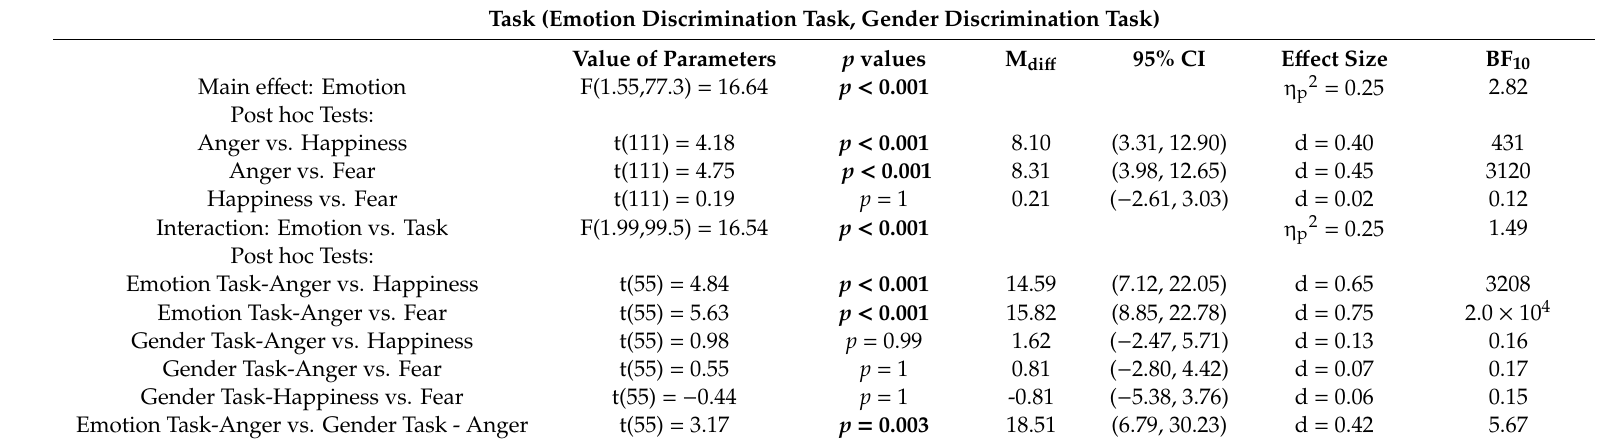
Table 3. Results of the statistical analysis of movement times (MTs). Post hoc tests (pairwise comparisons) had an adjusted alpha level corrected according to Bonferroni. Statistically significant results are reported in bold. Bayes factors report the ratio of likelihood of the alternative hypothesis to the likelihood of the null hypothesis (BF 10 ). ANOVA, analysis of variance. Measures of size effects: η p2 for ANOVAs and Cohen’s d for post hoc tests. Differences of the estimated marginal means (M diff ) are reported along their 95% confidence interval